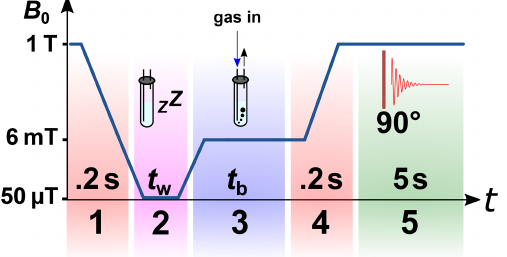
Figure 4. Scheme of the p H 2 quantification protocol. The NMR tube was flushed with N 2 , p H 2 , or rtH 2 gas for 180s before the exhaust was closed. A rest time of 30s was allowed for the system to settle down. Finally, the NMR spectra were acquired before the gas was released.